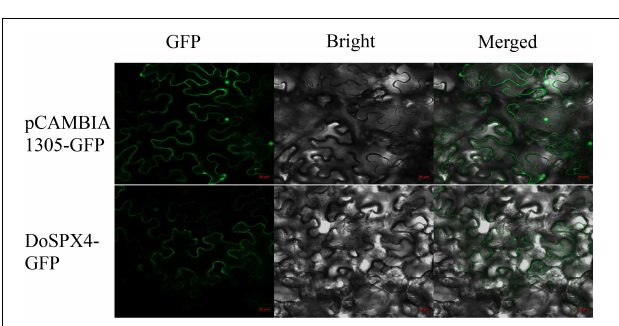
FIGURE 6 | The DoSPX4 interacts with DoPHR2. The pGADT7 and pGBKT7 were used as the negative control. SD-WL indicates the SD medium without Leu and Trp, and SD-HAWL means the SD medium without Ade, His, Leu, and Trp.